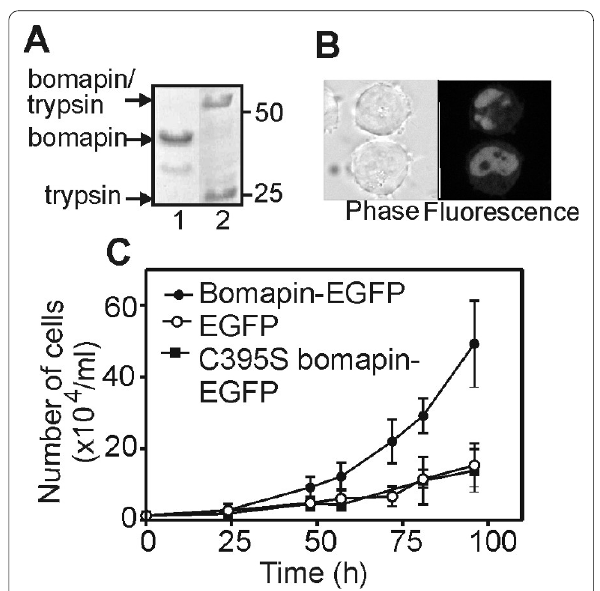
Figure 3 C395S bomapin mutant, representing reduced form of bomapin, does not enhance proliferation of K562 cells . (A) SDS- PAGE analysis (followed by Coomassie blue staining) of the E. coli ex- pressed and purified recombinant C395S bomapin mutant (lane 1) and the mutant protein incubated with a 4-fold molar excess of trypsin (lane 2). (B) Cellular localization of C395S-bomapin-EGFP in stably transfected K562 cells. (C) Proliferation of the stably transfected multi- clonal K562 cells expressing bomapin-EGFP, C395S-bomapin-EGFP, and EGFP alone, as measured by manual cell counting. Higher prolifer- ation of K562 cells expressing wt bomapin, compared to Fig. 2B, is due to higher generation number of the cells that were used in this exper-